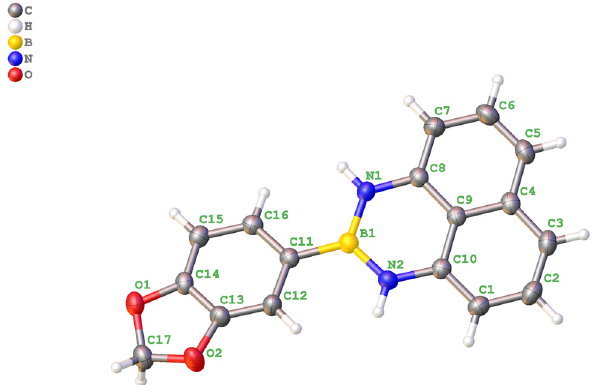
Table  : Data collection and